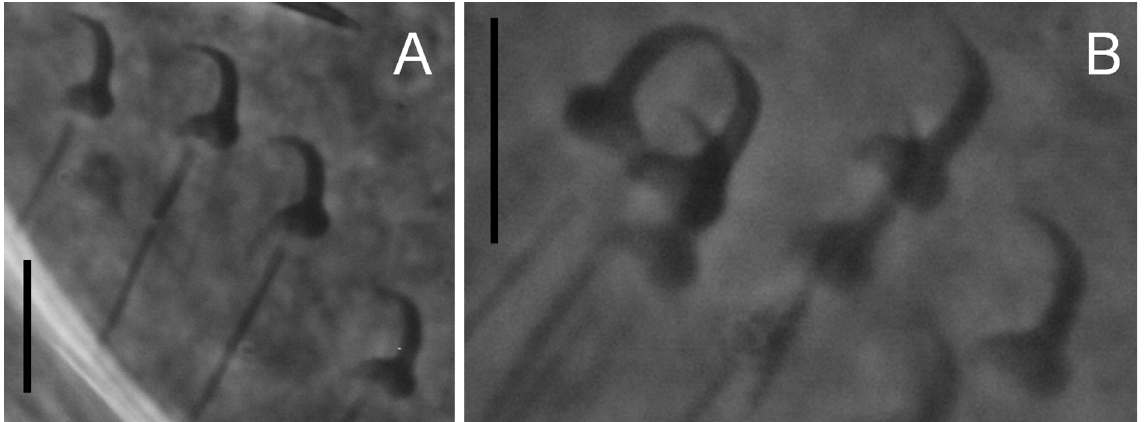
Fig. 2. A . micrograph detailing the marginal hooks of Gyrodactylus jalalii sp. nov. (photographed in utero , with an Olympus BX50 microscope, using phase contrast, and Olympus DP-soft v.3.2 software). B . idem, detail. Scale bars represent 8